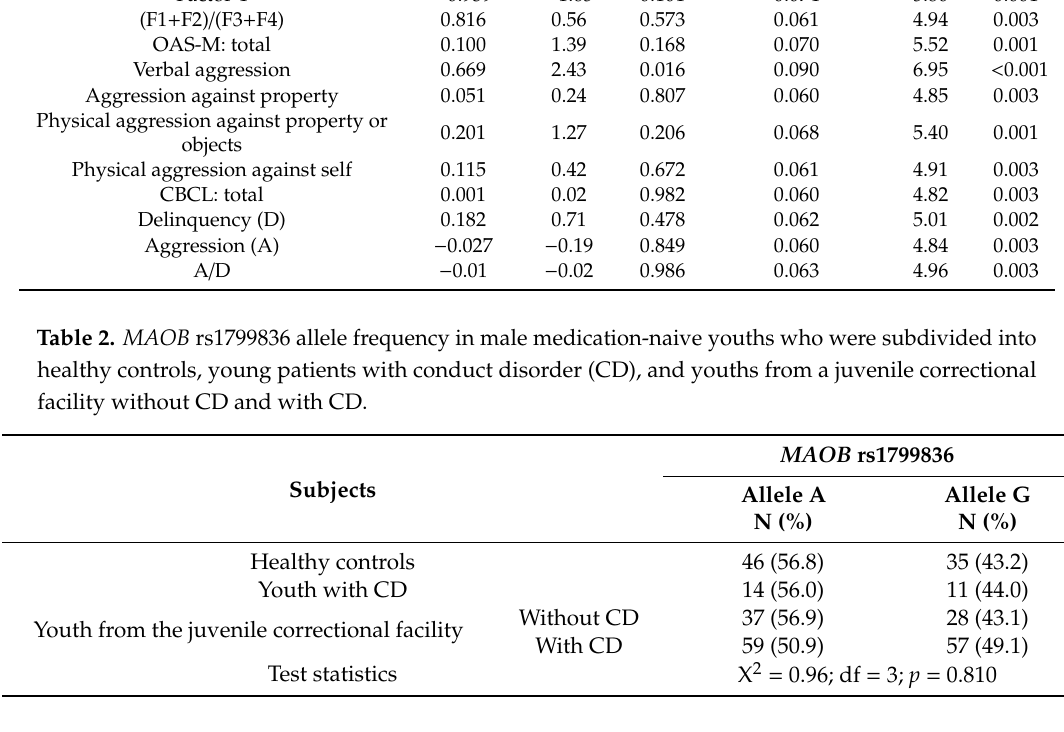
Table 3. MAOB rs1799836 allele frequency in male medication-naive youths who were subdivided into youths with or without court convictions, detainees with or without a record of attempted murder, and detainees who committed or who did not commit property